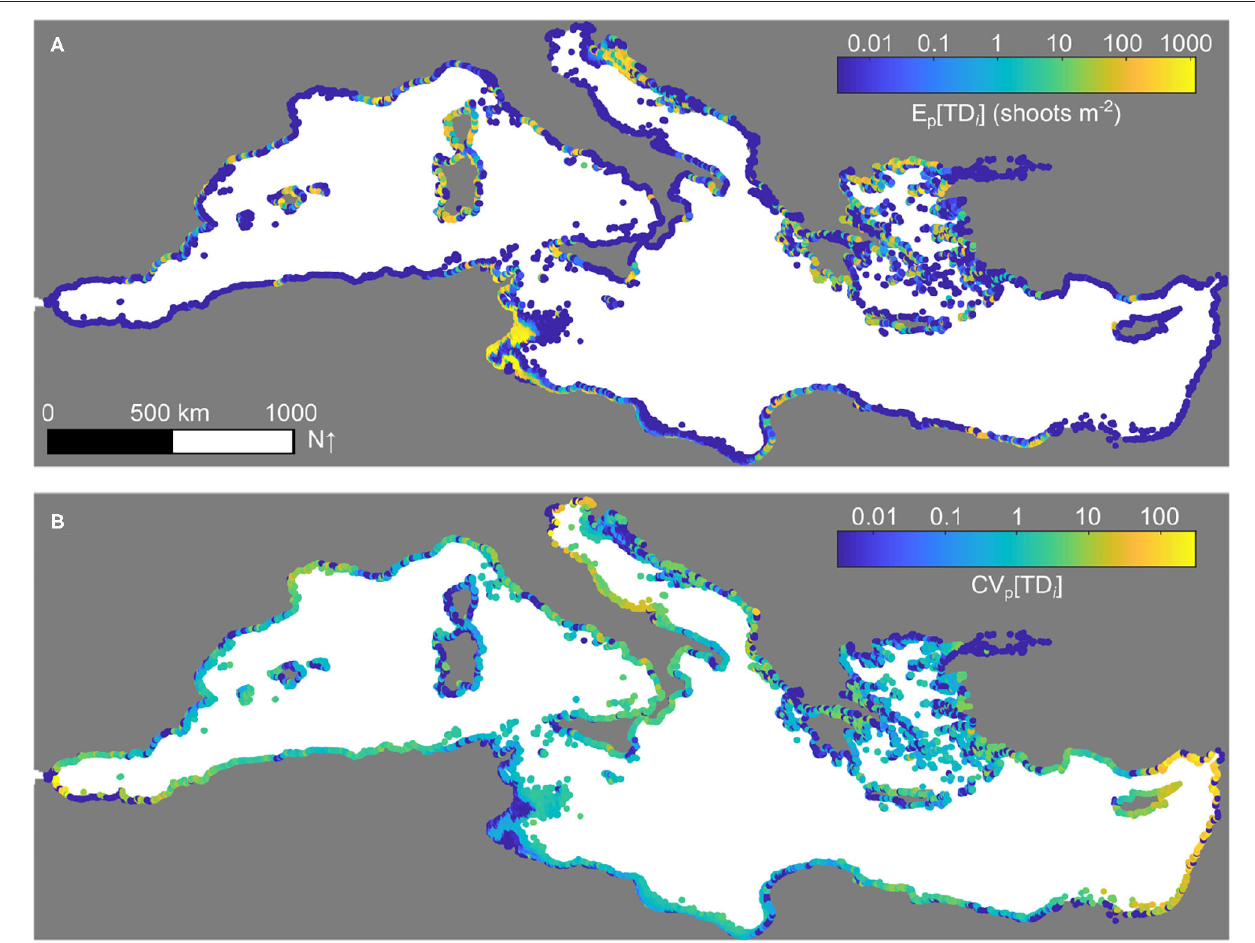
FIGURE 2 | Reference simulation of the P. oceanica metapopulation model. The model has been run starting from random initial conditions over a time span of 100 years with the average connectivity matrix h C ij i to allow the dynamics of the system to settle to a steady-state solution (shown in Figure 1A ), then for other 200 years with time-varying connectivity C ij ( t ) ( n r = 100 replicas). The pooled, across-replica, average (A) and coefficient of variation (B) of total shoot densities, evaluated for the last 100 years of the simulation, are shown in log 10 scale. Parameters as in Figure 1